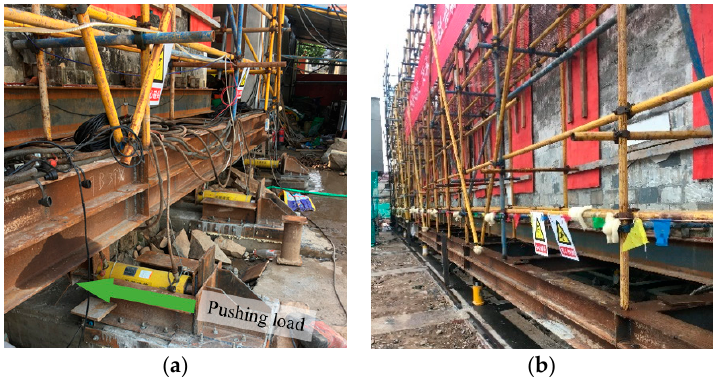
Figure 2 . The photos of ( a ) the push ‐ in moving process and ( b ) the mobile body.